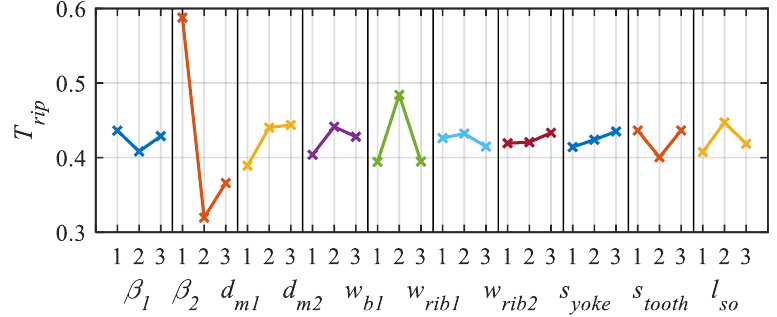
Figure 12. Plot of main factor effects on torque ripple ( T rip ).